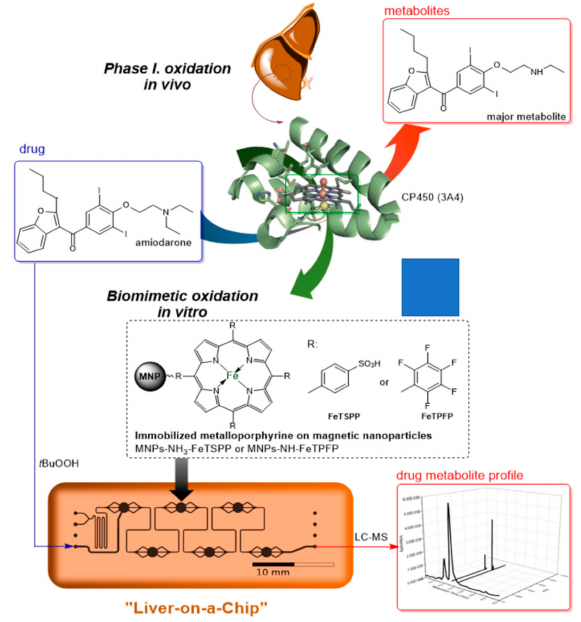
Figure 1. Biomimetic oxidation of amiodarone catalyzed by metalloporphyrines immobilized on magnetic nanoparticles in continuous-flow magnetic chip